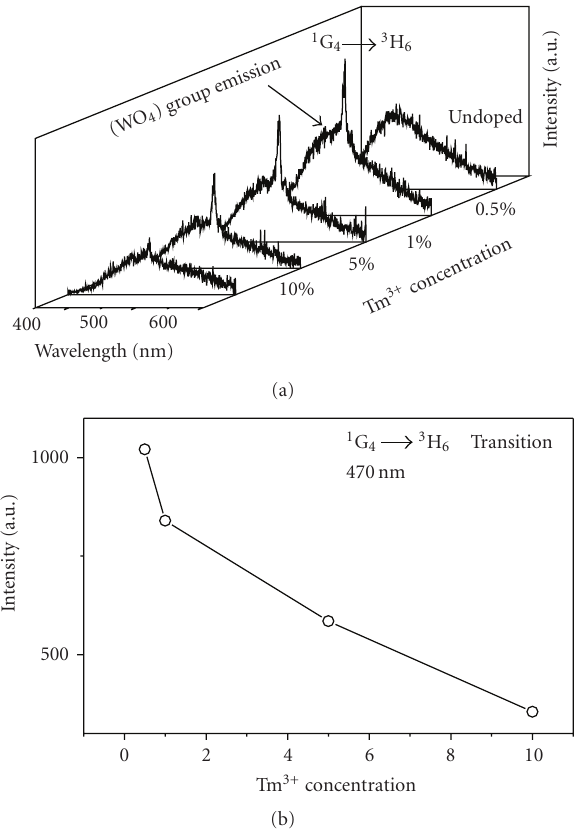
Figure 8: (a) Room temperature emission spectra of LiIn 1 − x Tm x (WO 4 ) 2 ( x = 0, 0.5, 1, 5, and 10 at.%) excited at 285nm, (b) Integrated emission intensity for 1 G 4 → 3 H 6 transition (470nm) in LiIn(WO 4 ) 2 as a function of Tm 3+ concentration.